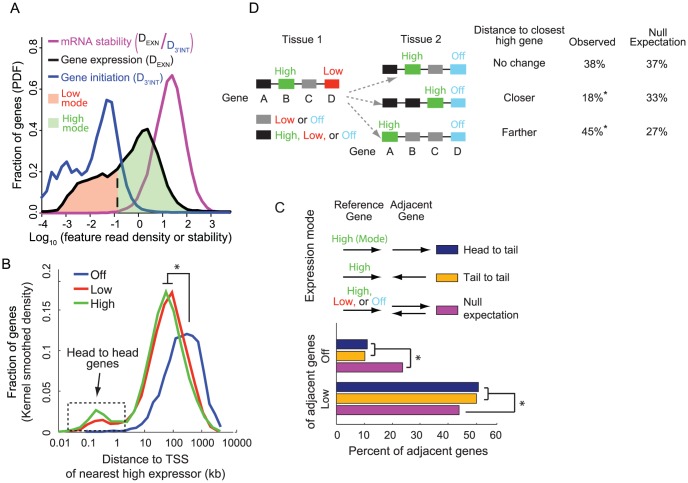
Bimodality of mRNA synthesis rates reflects genome organization.(A) Distributions of gene expression levels (DEXN), mRNA synthesis rates (D3′INT), and mRNA stability (DEXN/D3′INT) reveal two modes of gene expression. DEXN and D3′INT refer to the RNA-Seq read densities across exons and the 3′-most 10 kb of introns respectively. (B) Compared to genes that are not expressed, low and high expressors are found closer to highly expressed genes. The x-axis indicates the distance from a gene's transcription start site (TSS) to the TSS of the nearest high expressor; * indicates p<10−3 by a two-sample K-S test. (C) Genes adjacent to high mode genes are disproportionately more likely to be in the low mode and less likely to be in the off mode of gene expression, for both head-to-tail and tail-to-tail gene pair architectures (* indicates p<10−6 from a bootstrap simulation with one million iterations, in which expression classes were permuted). (D) Between tissues, when genes transition from low expressors to non-expressors, their average distance to the nearest high expressor increases (p<2.2×10−16, based on a chi-square test). The ∼15% difference between the data and the randomized control suggests that at least 15% of the changes from low to off are due to a nearby gene being up-regulated. RNA-Seq data is from mouse cortical neurons sequenced using SOLiD [53] (A–C) and ten human tissues (D).